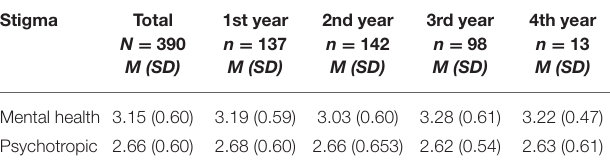
TABLE 3 | Participants’ stigma scores by year in Pharm. D.